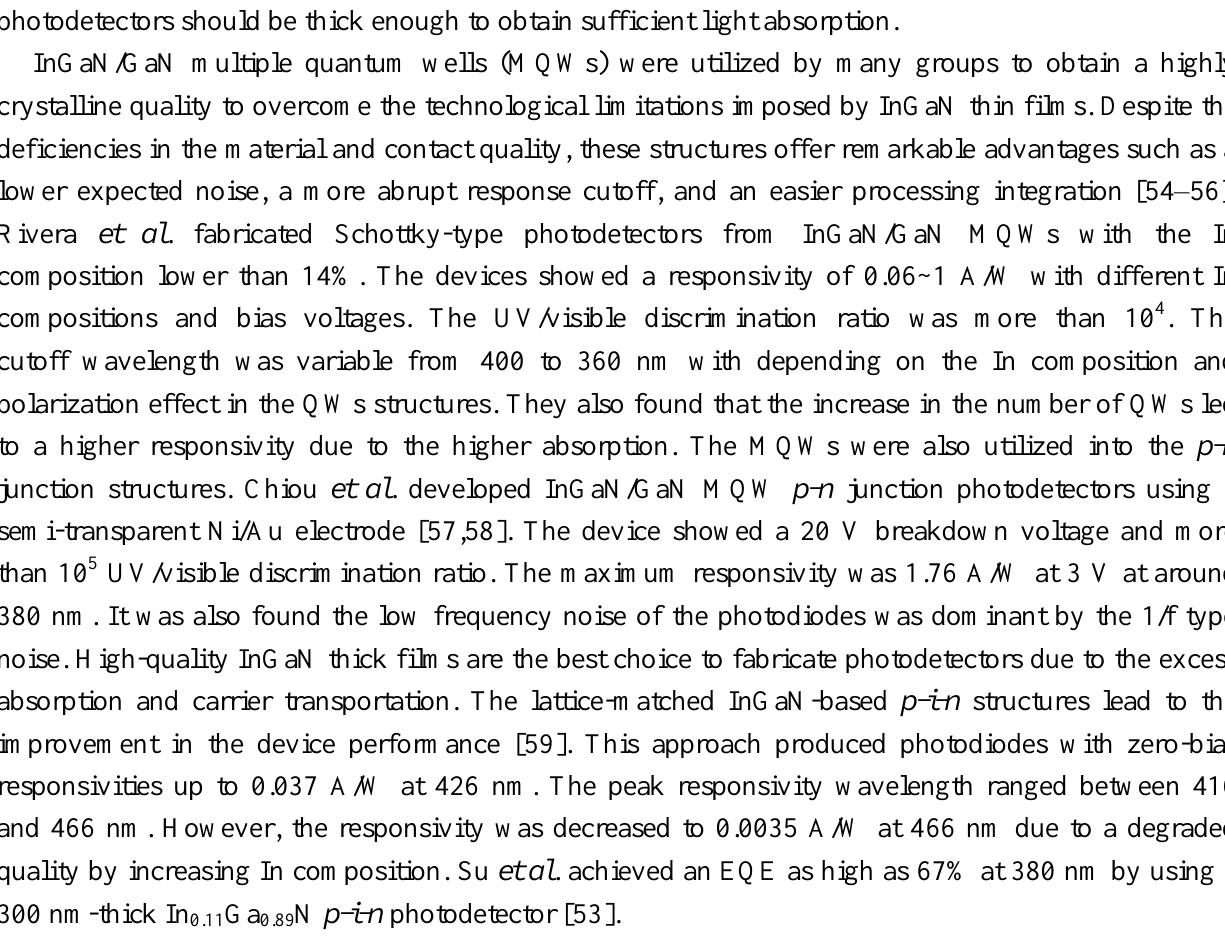
Table 1. InGaN-based visible-blind photodetector using different insulators. Dark Structure Current